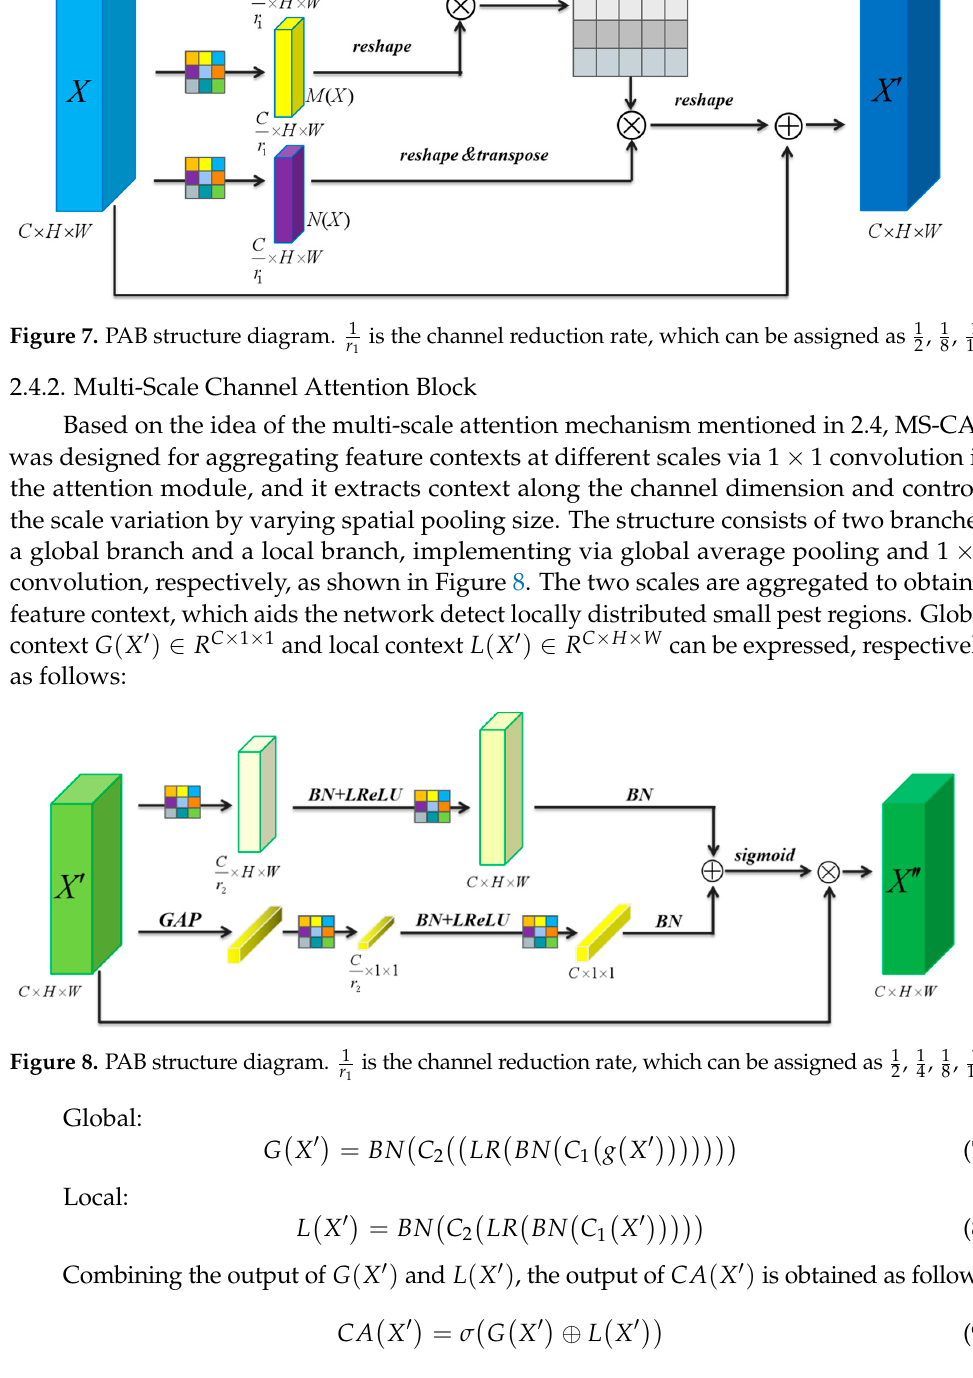
Figure 7. PAB structure diagram. (cid:2869)